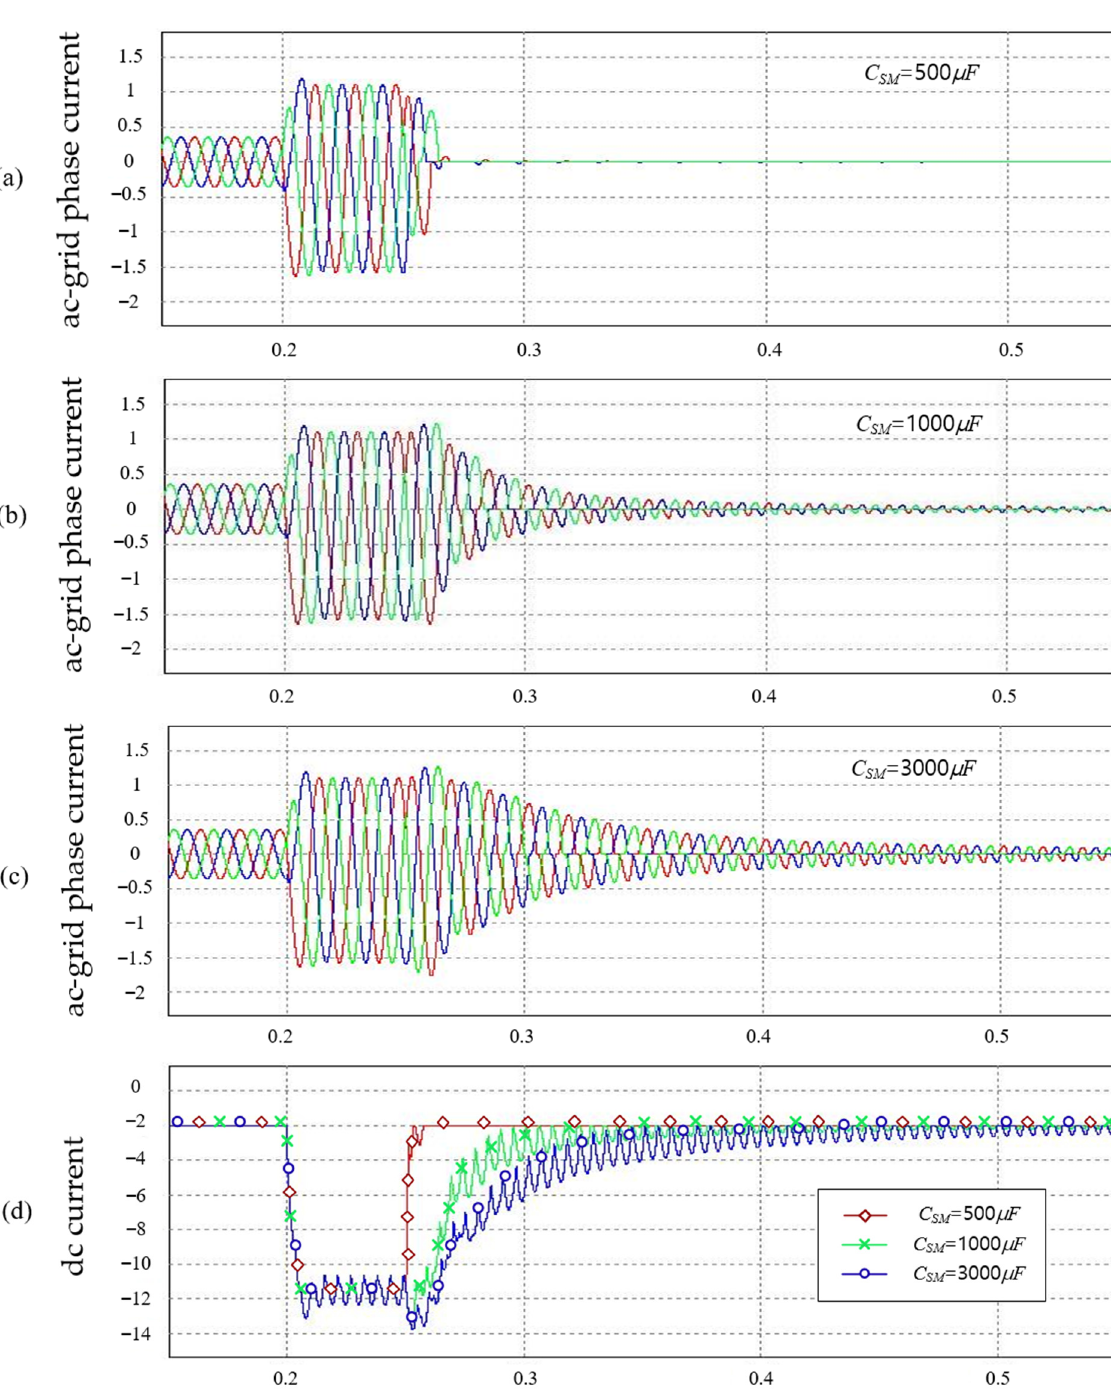
Figure 15. AC and DC current under different sub-module capacitance.